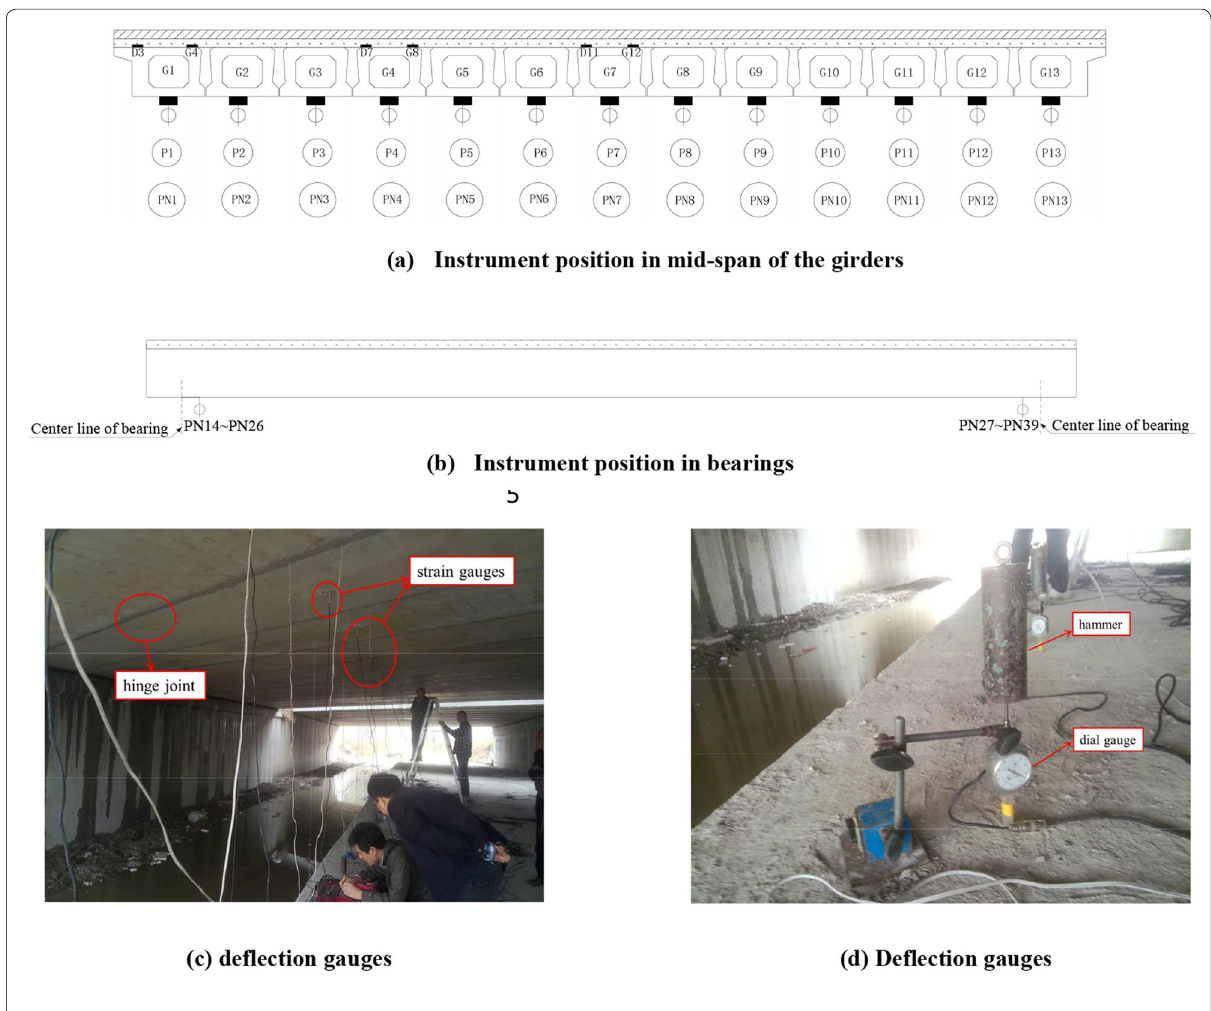
Fig. 8 Instrument arrangement in the vehicle loading test. Note: Pi: strain point, PNi: deflection point.